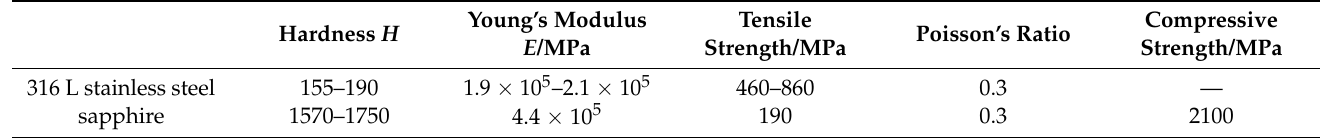
Table 1. The mechanical properties of stainless steel and sapphire used in the